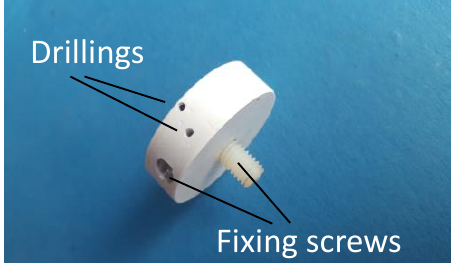
Safety 2018 , 4 , x Figure 3. Photo of a PVC-sample with drilling for thermocouples. Figure 3. Photo of a PVC-sample with drilling for thermocouples.